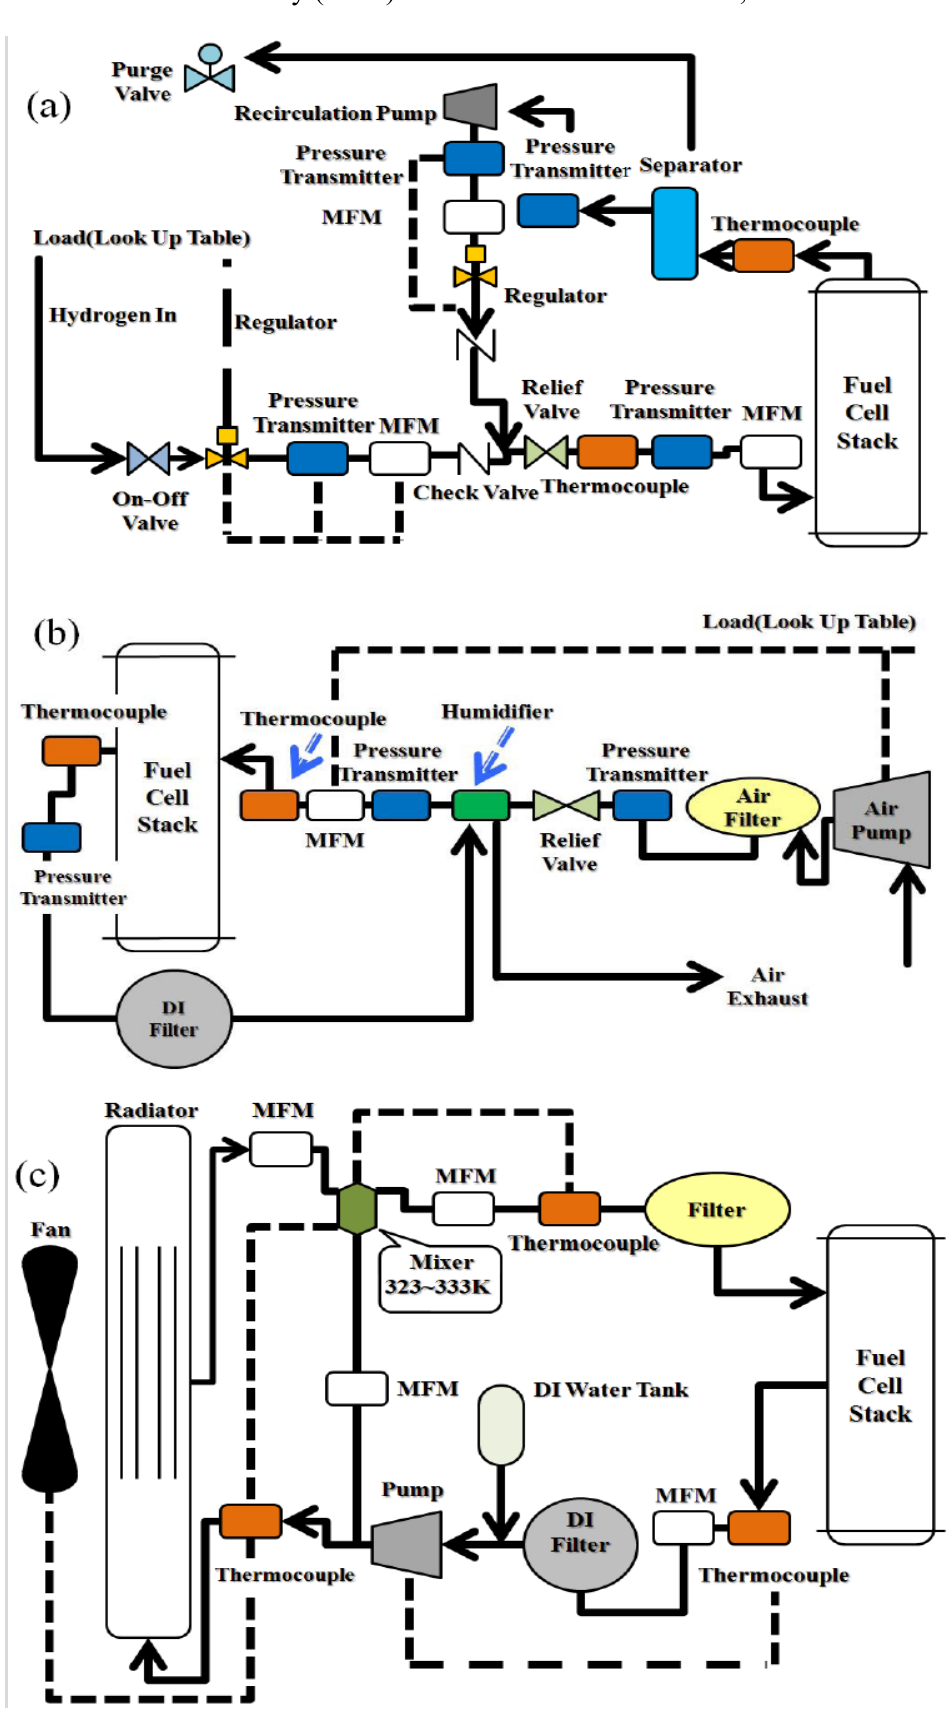
Figure 2. The testing facility of fuel supply, oxidant supply and water cooling system in the National Taiwan University (NTU) lab. MFM: mass flow meter; and DI: